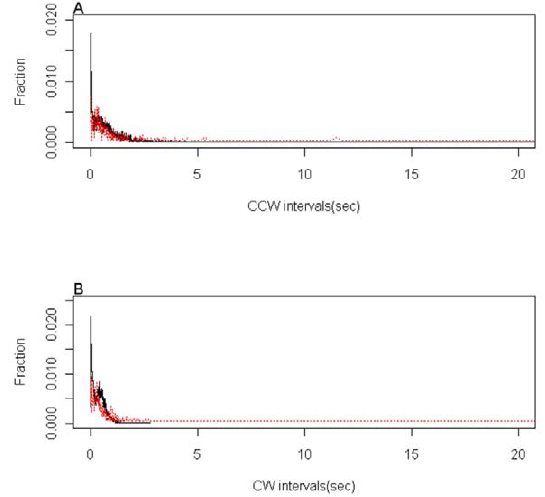
Figure 3. The counter-clockwise and clockwise interval distri- butions for the freely diffusing CheZ